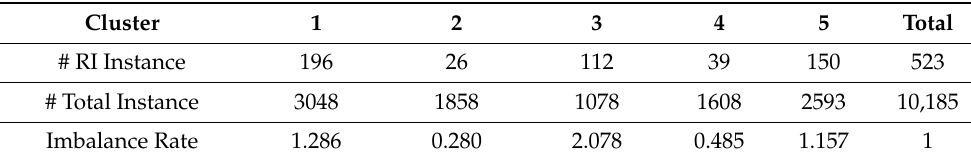
Table 3. The number of minority and total cases, and the imbalance rate (with population RI ratio at 5.1%) for the 5 clusters generated by GMM.